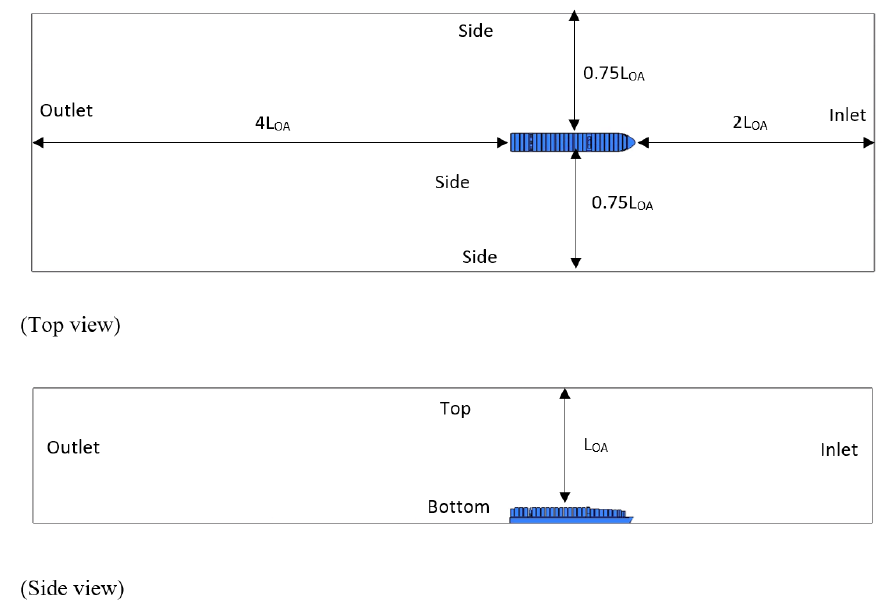
Figure 2. Computational domains.